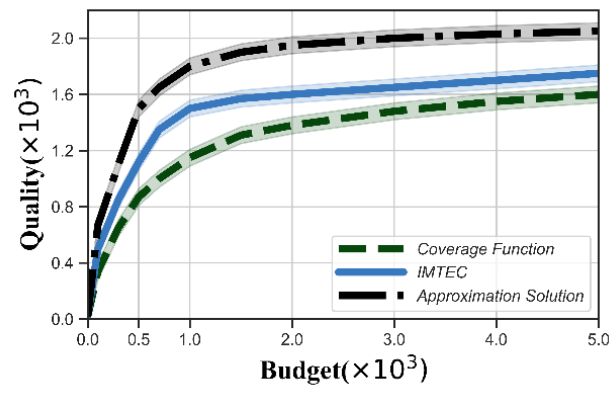
Figure 8. Quality function versus budget.